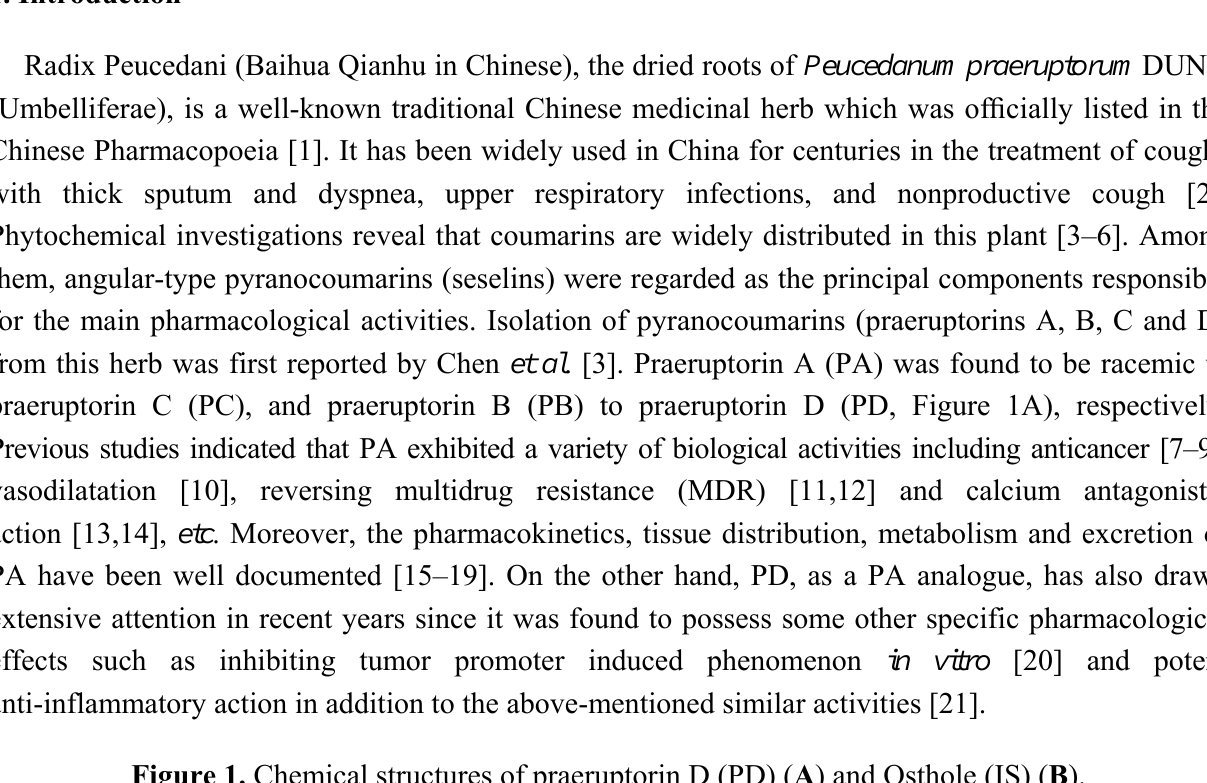
Figure 1. Chemical structures of praeruptorin D (PD) ( A ) and Osthole (IS) ( B